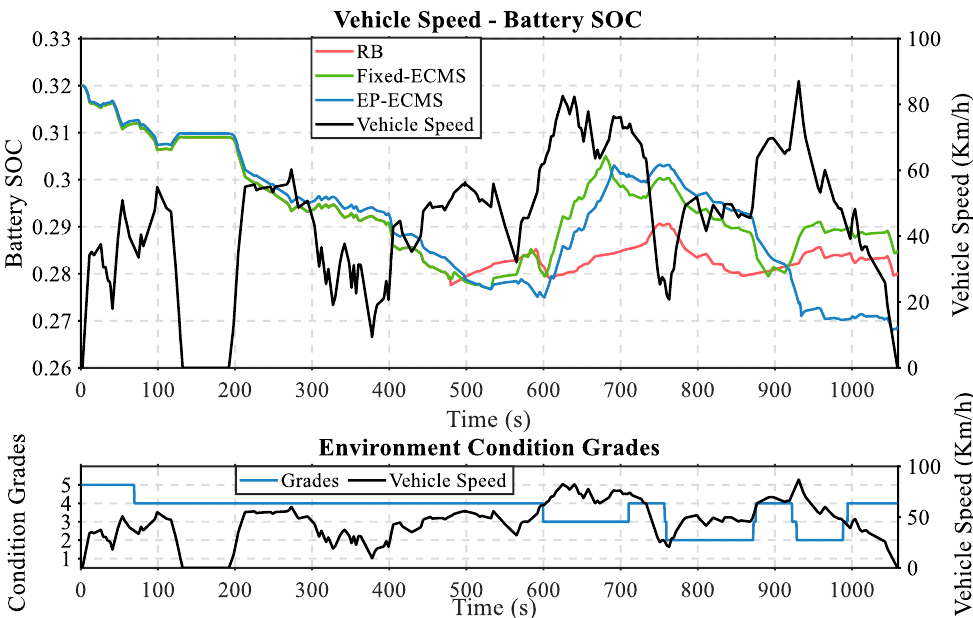
Figure 11. The first random working condition test result.